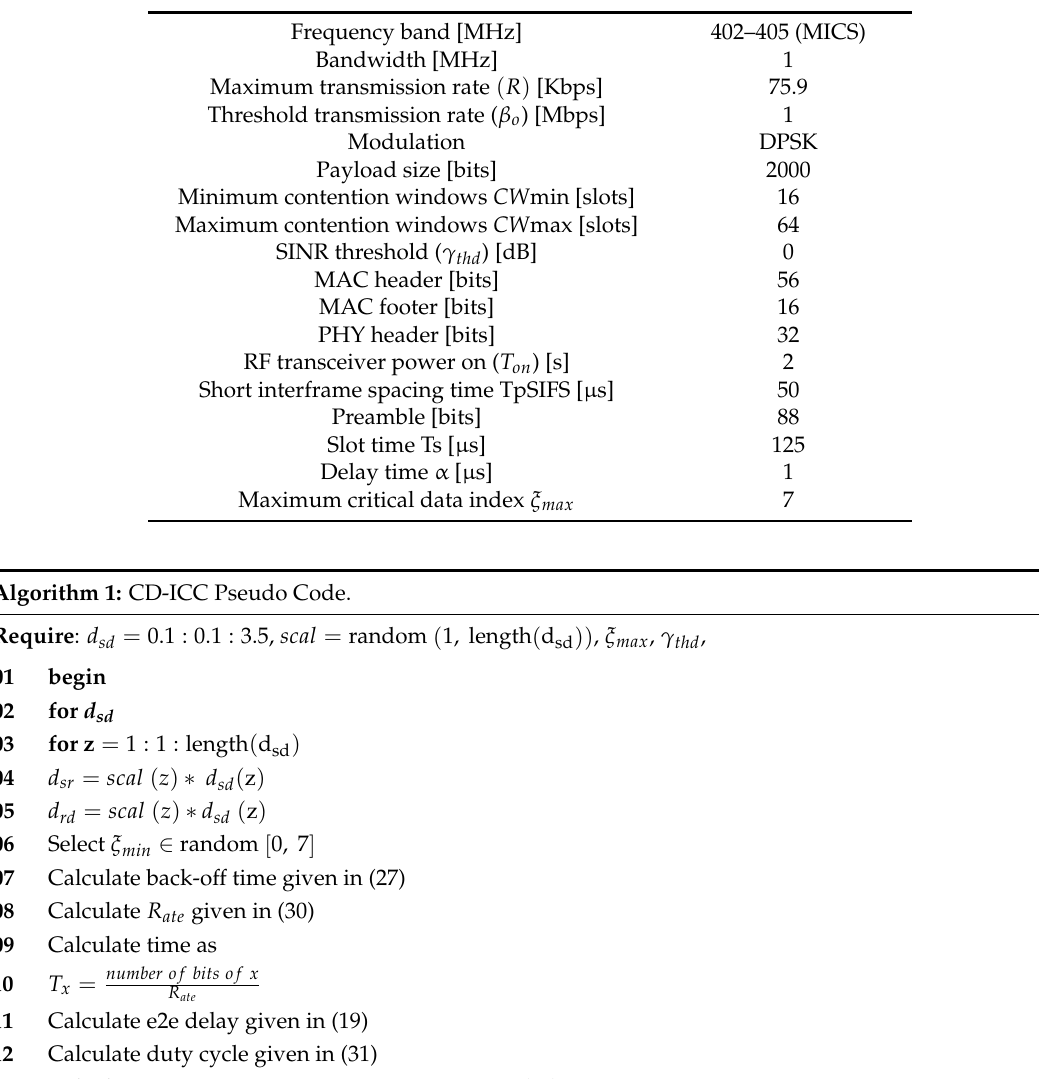
Table 3. Numerical parameters.